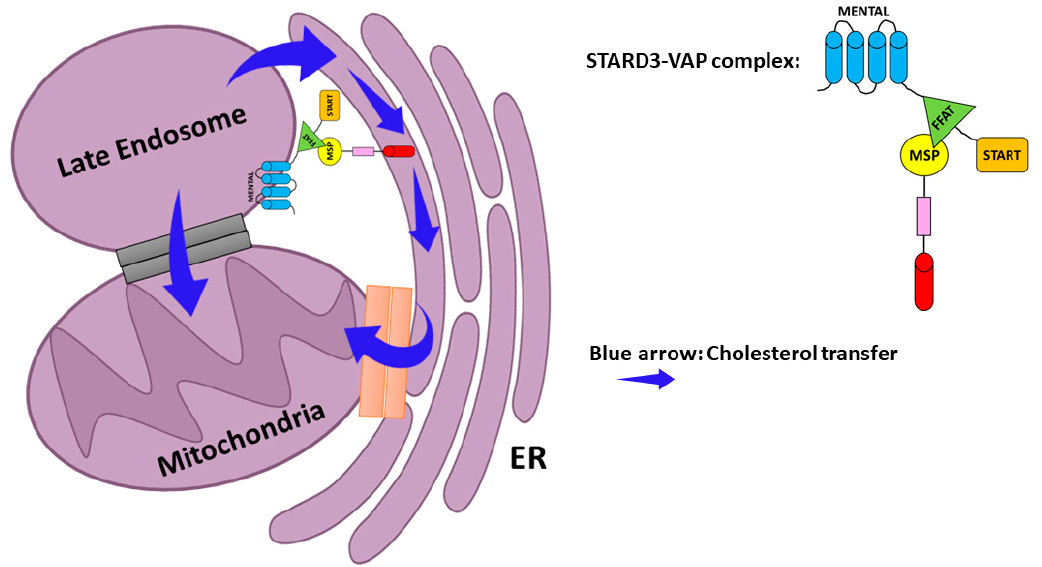
Figure 4. Possible model for cholesterol transport to mitochondria. ER–Late endosome interaction via the STARD3–VAP complex. Cholesterol is sorted to the mitochondria via either the ER–mitochondria MCS or MAM (mitochondria-associated ER membrane) (orange). Contact between endosome membranes and the mitochondrial membrane also allows direct transfer of cholesterol (Gray). Blue arrow—cholesterol transfer.